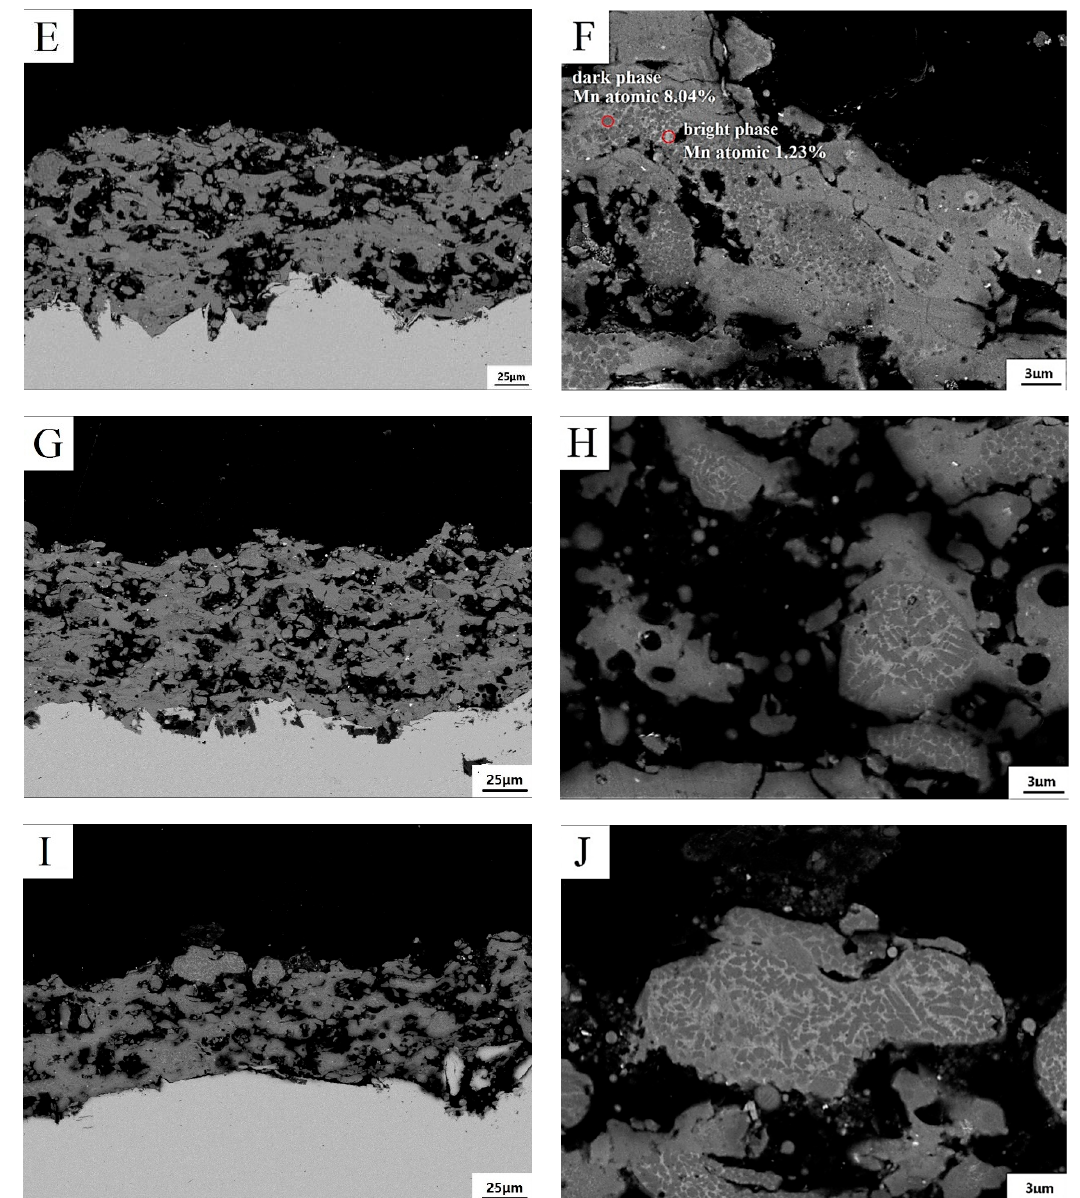
Figure 6. Low and higher magnification view of the cross section of coating with di ff erent composition. ( A , B ): 5MnO x / 5CeO 2 / TiO 2 coating; ( C , D ): 10MnO x / 5CeO 2 / TiO 2 coating; ( E , F ): 20MnO x / 5CeO 2 / TiO 2 coating; ( G , H ): 30MnO x / 5CeO 2 / TiO 2 coating; ( I , J ): 40MnO x / 5CeO 2 / TiO 2 coating.